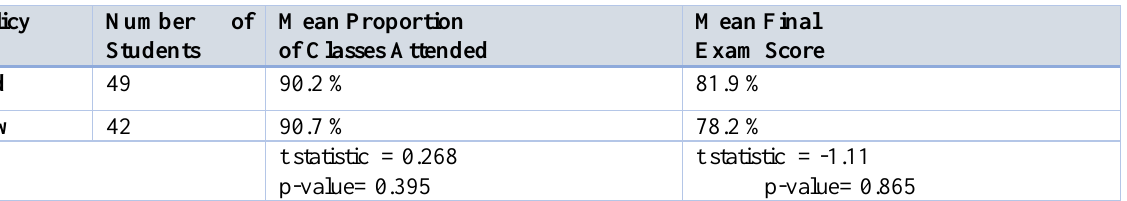
Mean Proportion of Classes Attended for Physical Chemistry